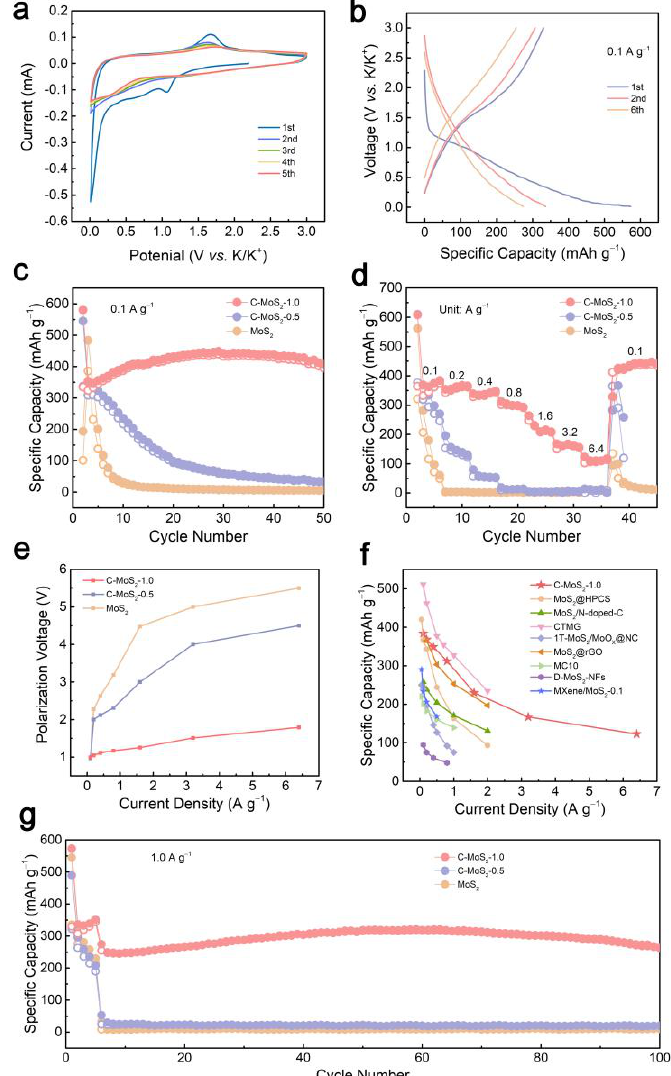
Figure 4. Electrochemical performance of samples. ( a ) CV profiles of C-MoS 2 -1. ( b ) GCD curves of C-MoS 2 -1 electrode at a current density of 0.1 A g −1 . ( c ) Cycling performance of MoS 2 and C-MoS 2 electrodes at 0.1 A g −1 . ( d ) Rate capability and ( e ) polarization voltage comparison under different current densities of MoS 2 and C-MoS 2 electrodes. ( f ) The comparison of the rate capability between C-MoS 2 -1.0 and the other reported MoS 2 -based anodes for PIBs. ( g ) Cycling performance of MoS 2 and C-MoS 2 at a current density of 1.0 A g −1 .